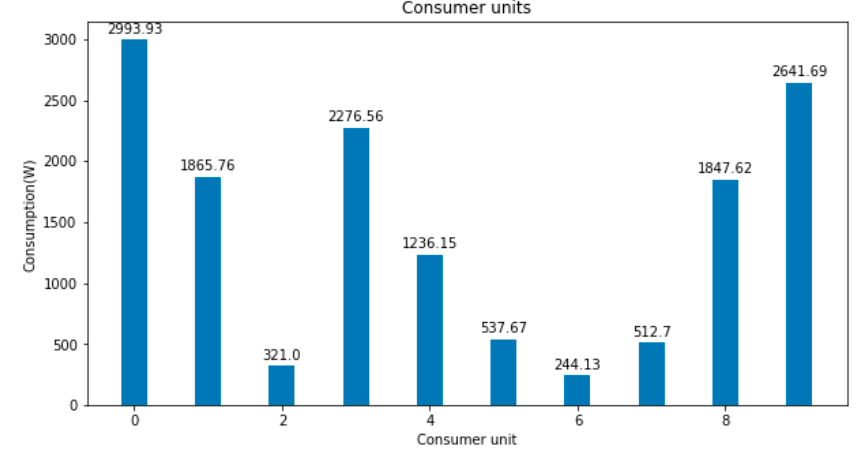
Figure 5. Example of consumers units generated by simulator.